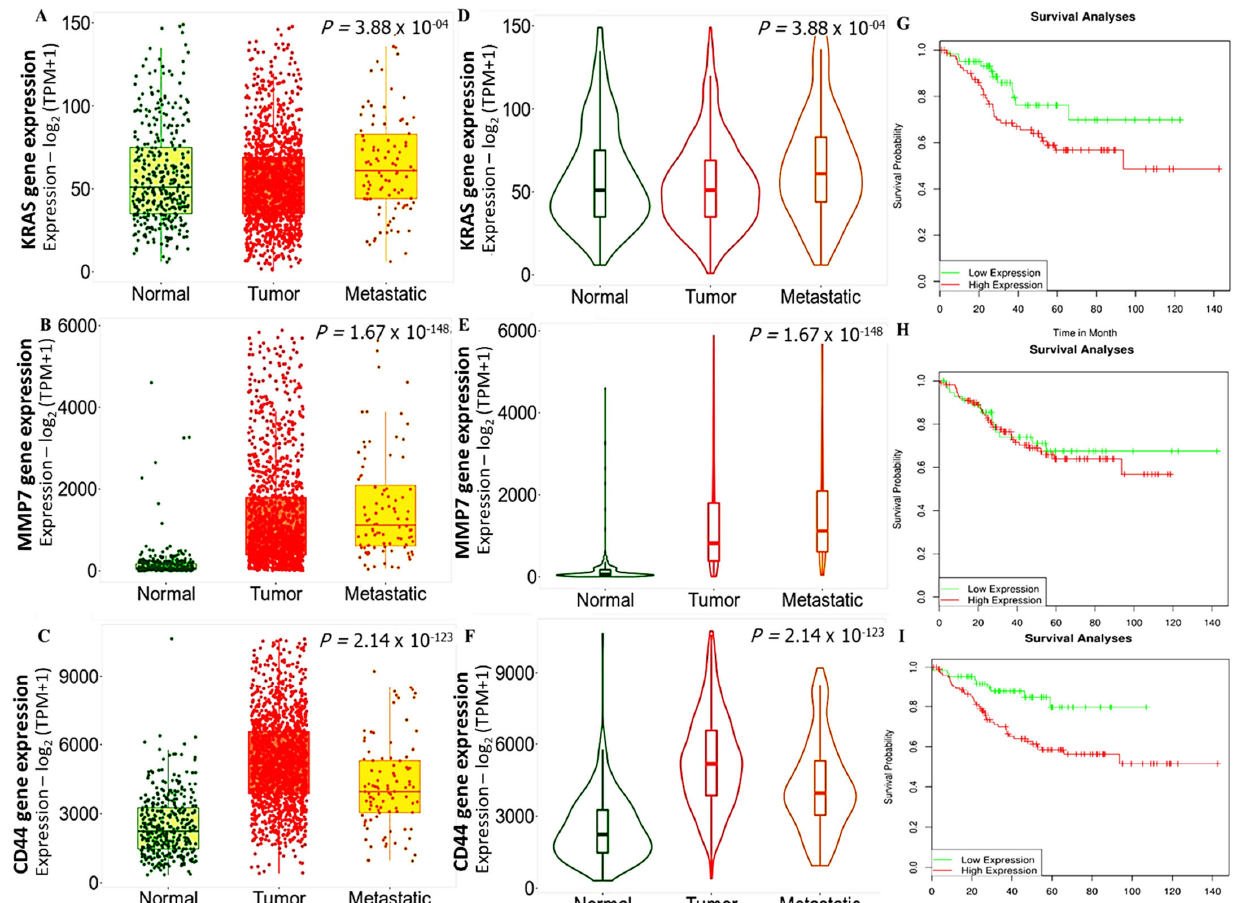
Figure 2. Increased expressions of the KRAS, MMP7, and CD44 oncogenes were associated with colorectal cancer (CRC) tumor and distant metastasis. ( A – C ) Boxplots and ( D – F ) violin plots of increased levels of the KRAS, MMP7, and CD44 oncogenes in CRC tumor and metastatic samples compared to normal samples. The analysis was based on the Kruskal–Wallis test and Dunn’s test. ( G–I ) Kaplan–Meier plot survival analysis showing that, the overexpression of KRAS/MMP7/CD44 associated with poor overall survival in CRC, with p < 0.05 considered statistically significant.